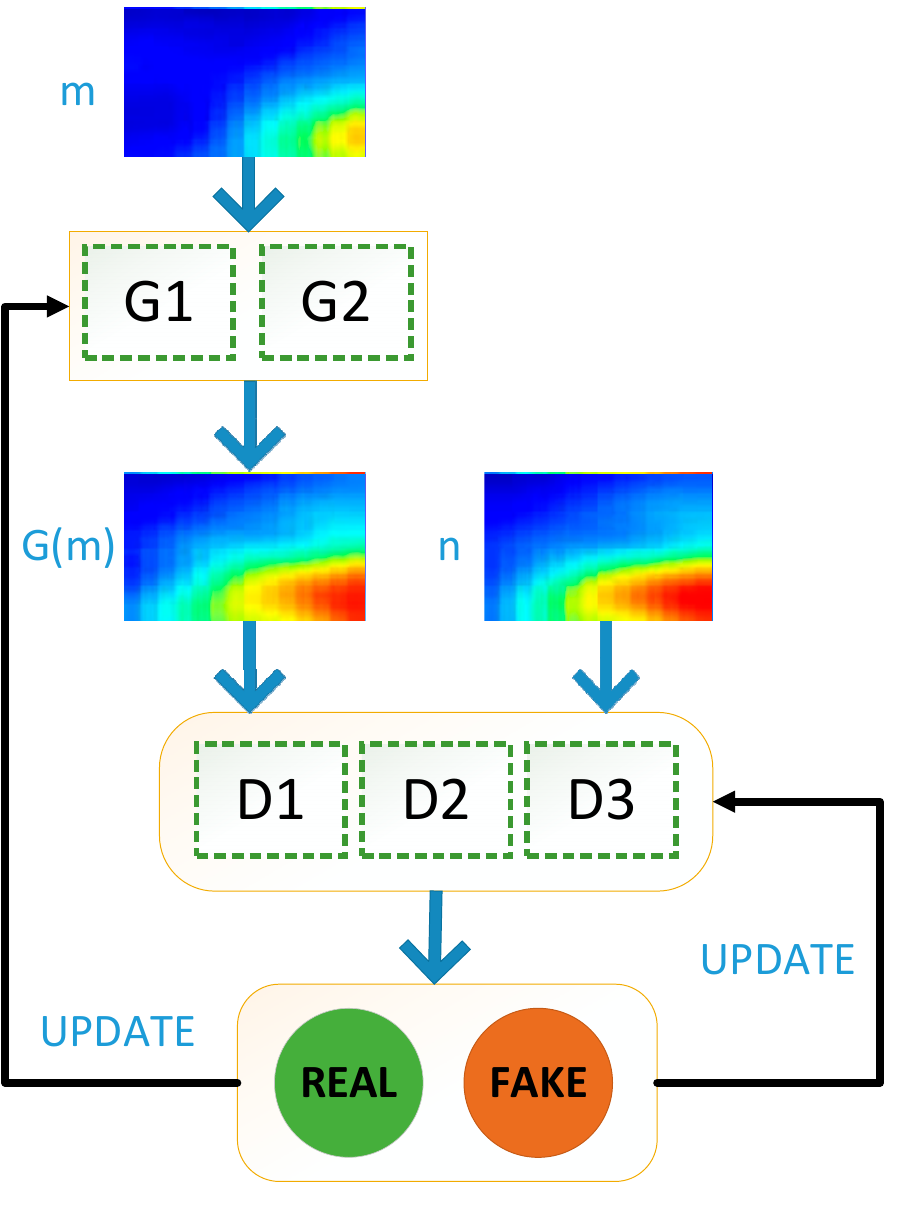
Figure 1. The structure of our model.